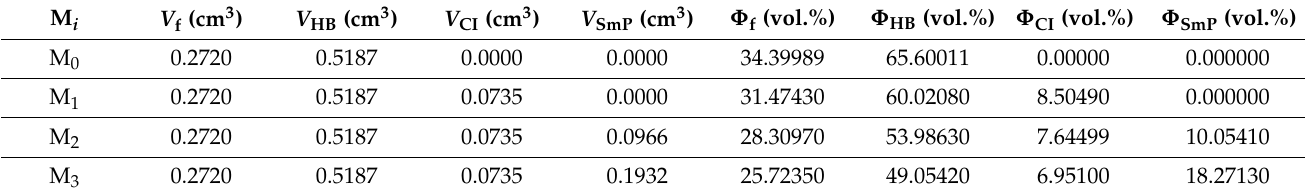
Table 3. Volumes and volume fractions for the components of membranes M i ( i = 0,1,2,3 )